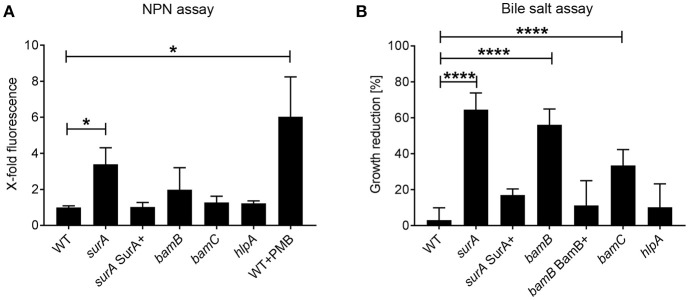
Role of SurA, BamB, BamC, and HlpA for membrane integrity and sensitivity against bile salts. (A) NPN Assay. A conditional surA and bamB, bamC, and hlpA deletion mutants were treated with NPN. Data depict the mean and SD of 3–5 independent experiments with triplicates. The fluorescence signal derived from matched numbers of bacteria was compared to that of WT. Polymyxin B (PMB) was used as a positive control. Asterisks indicate significant differences (p < 0.05) compared to WT using ANOVA analysis. (B) Bile Salt Assay. Growth of the indicated Pa strains was measured in the absence or presence of 0.3 % bile salts after 8 h. Data depict the mean and SD of the growth reduction in 0.3 % bile salts in LB compared to LB alone of at least 3 independent experiments with duplicates. Asterisks indicate significant differences (****p < 0.0001 or *p < 0.05) as analyzed by ANOVA analysis.